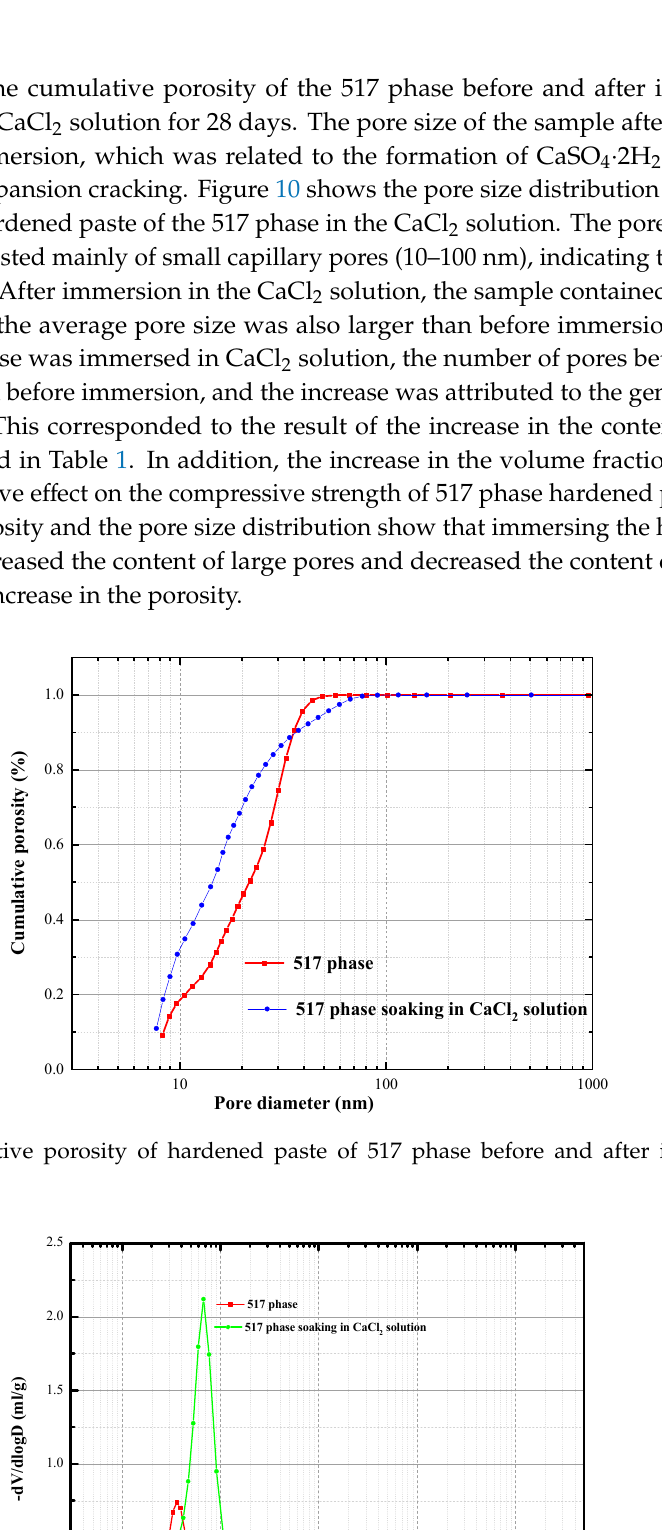
Figure 8. SEM images of 517 phase before and after soaking in different solutions: ( a ) before soaking; ( b ) after soaking in NaCl solution for 28 days; ( c , d ) after soaking in CaCl 2 solution for 28 days.